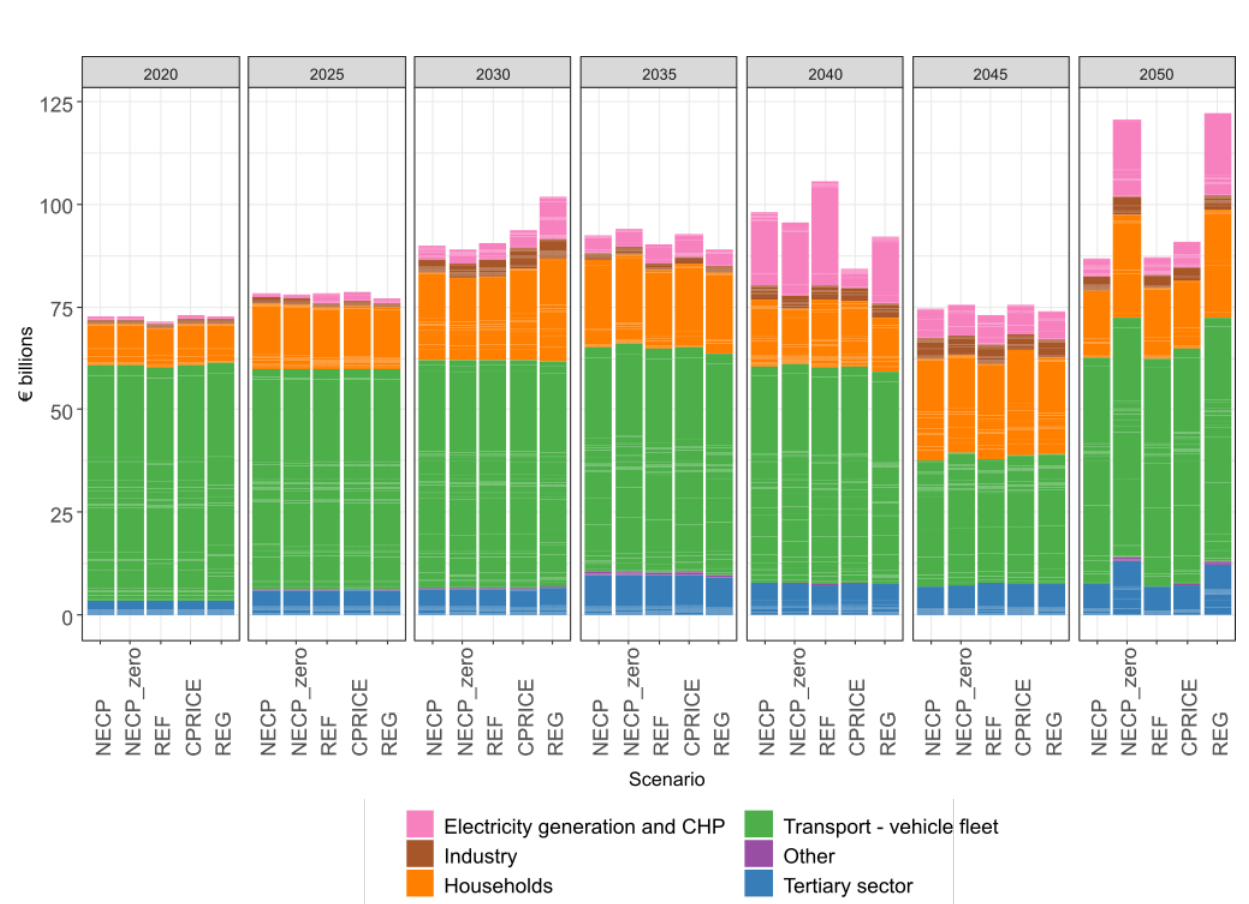
Figure 9. Investment cost by sector (sum over 5-year period, EUR 2020, without VAT).